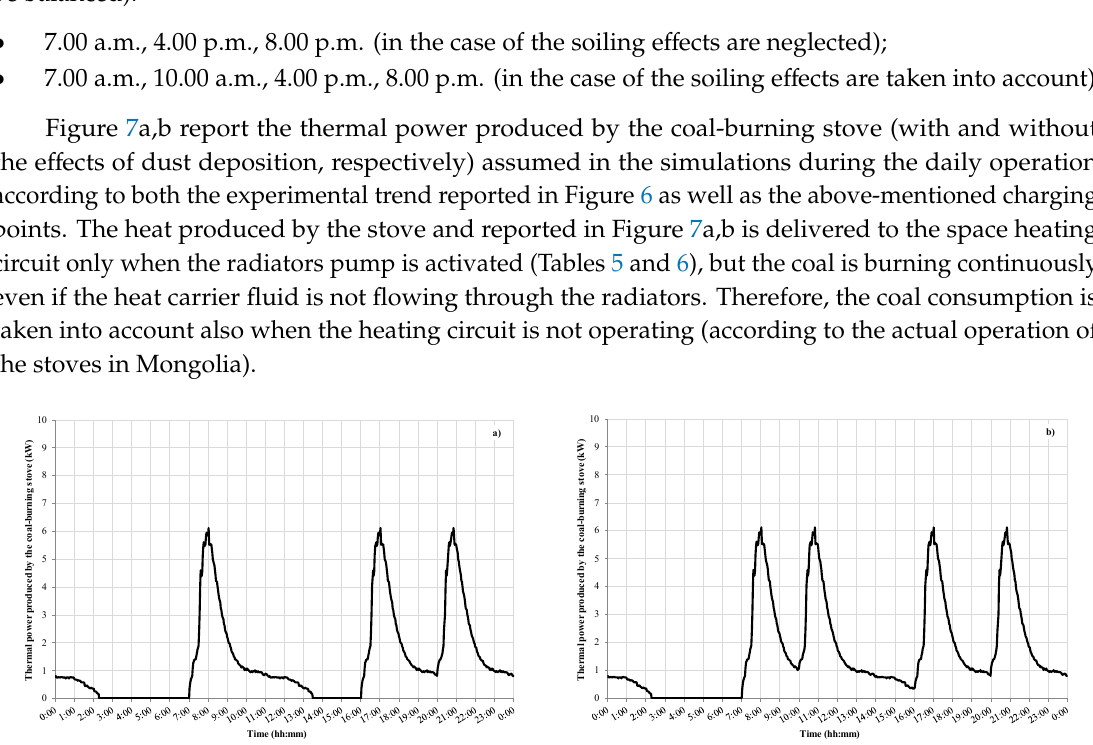
Figure 7. Daily thermal power produced by the stove for ( a ) the proposed system without dust deposition and ( b ) the proposed system with dust deposition.